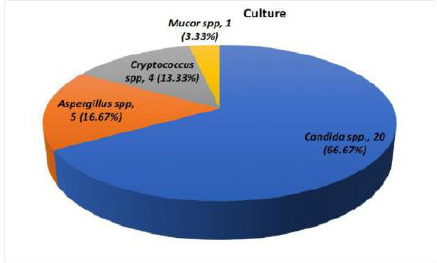
Fig. 3. Frequency of fungal among patients with respiratory disease detected by culture